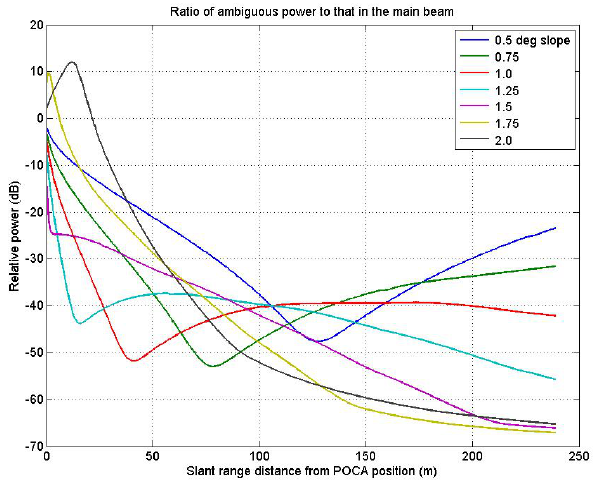
Fig. 3. Ratio of the interferogram power in the ambiguous beam to that in the main beam for cross-track slopes between 0.5 and 2.0 ◦ based on a locally spherical Earth model. The minimum in the suppression of the ambiguous power occurs when the ambiguous footprints are illuminated by the low antenna gain region between the main lobe and the first side lobe at ∼ 1.5 ◦ from nadir.